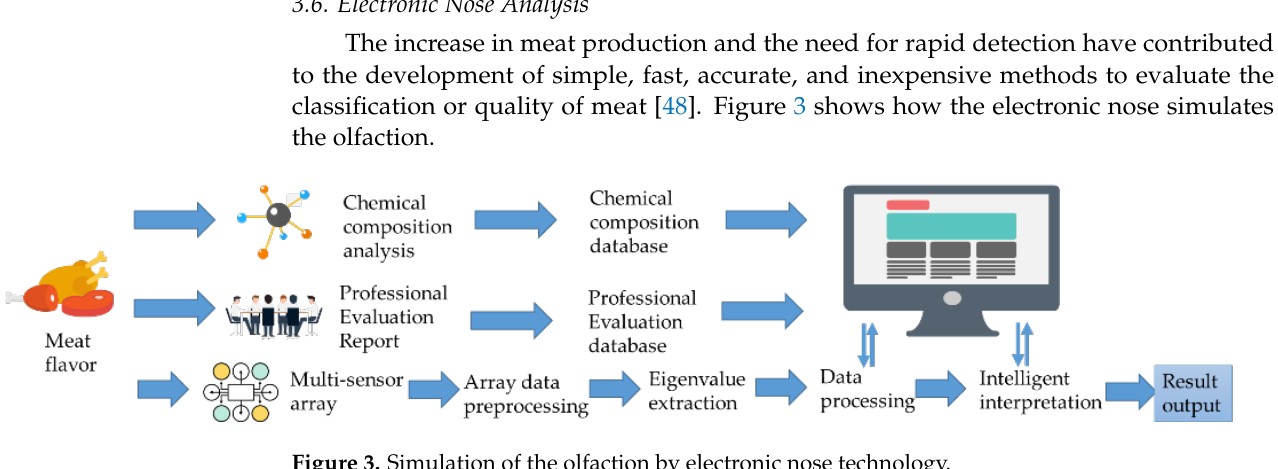
Figure 3. Simulation of the olfaction by electronic nose technology.